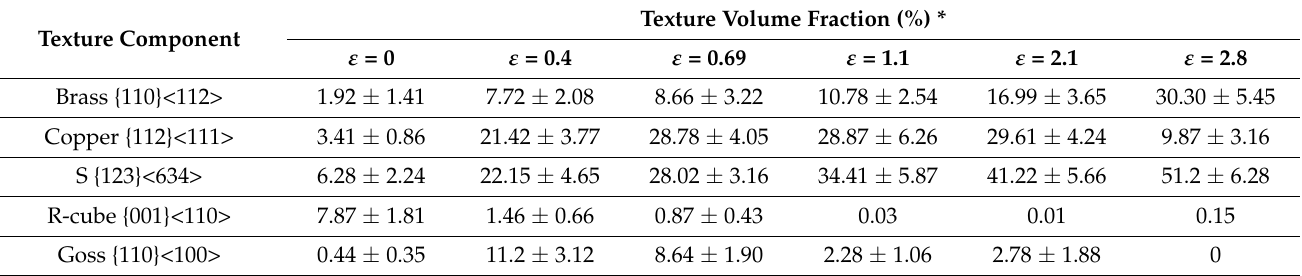
Table 2. Texture development, based on EBSD measurement, as a function of strain during PSC at 77 K. Texture